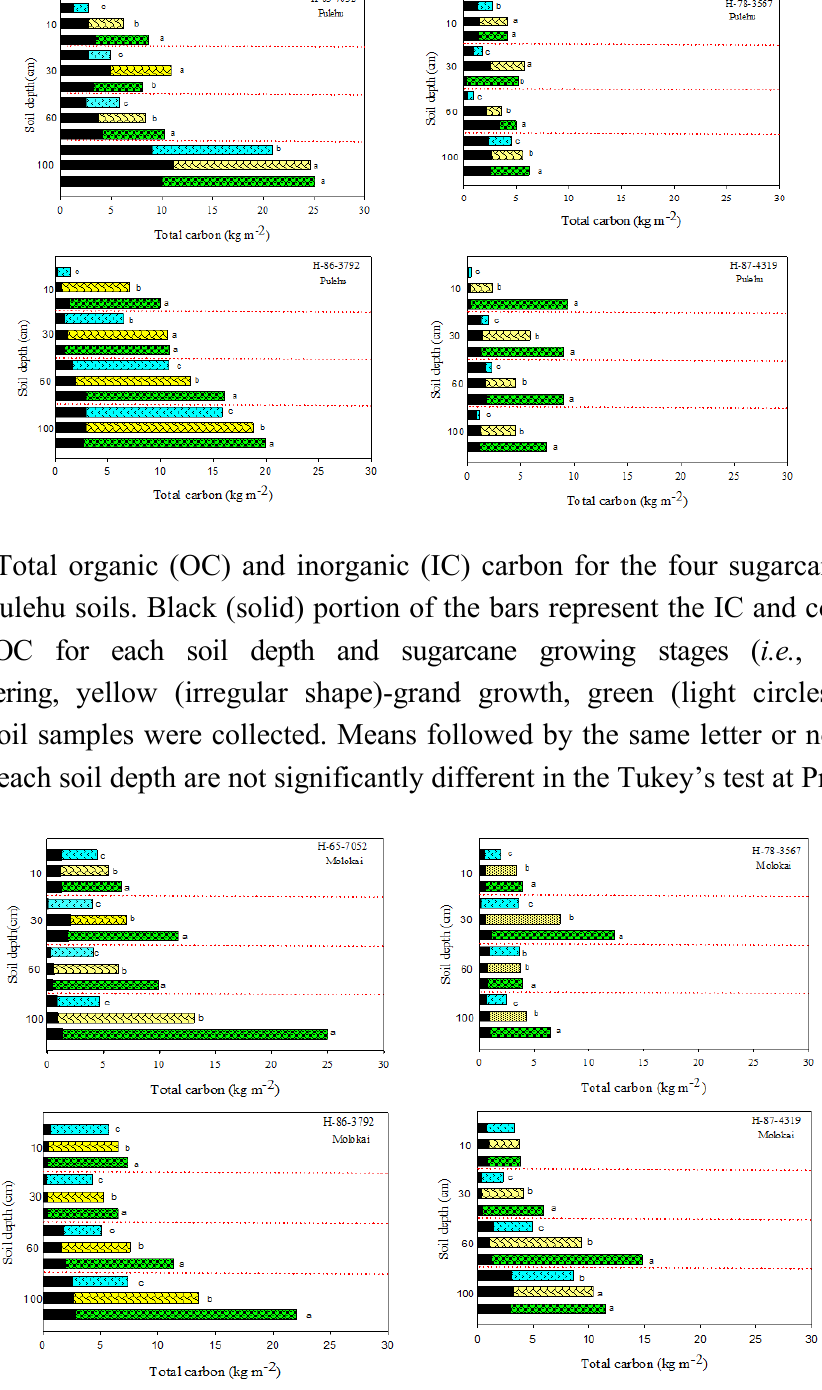
Figure 2. Total organic (OC) and inorganic (IC) carbon for the four sugarcane cultivars growing in Molokai soils. Black (solid) portion of the bars represent the IC and color portion represent OC for each soil depth and sugarcane growing stages ( i.e. , blue (open arrows)-tillering, yellow (irregular shape)-grand growth, green (light circles)-maturity) when the soil samples were collected. Means followed by the same letter or no letters for the bars in each soil depth are not significantly different Tukey’s test at Pr <